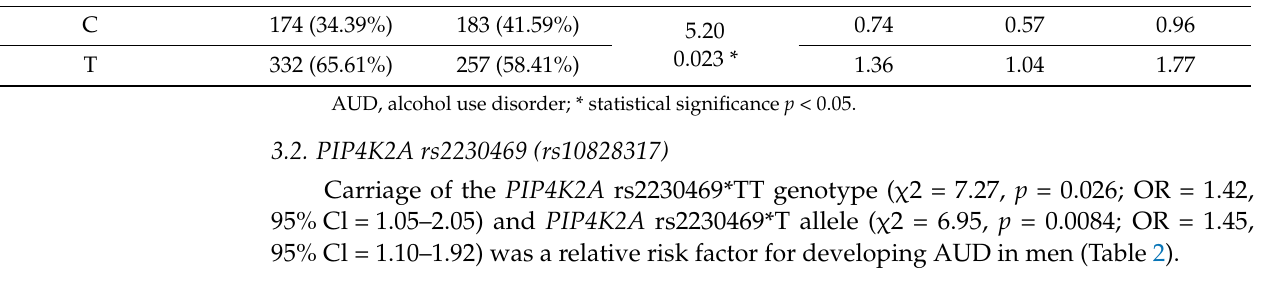
Table 2. The comparison of PIP4K2A rs2230469 genotypes and alleles distribution in men with AUD and healthy men. Genotypes/